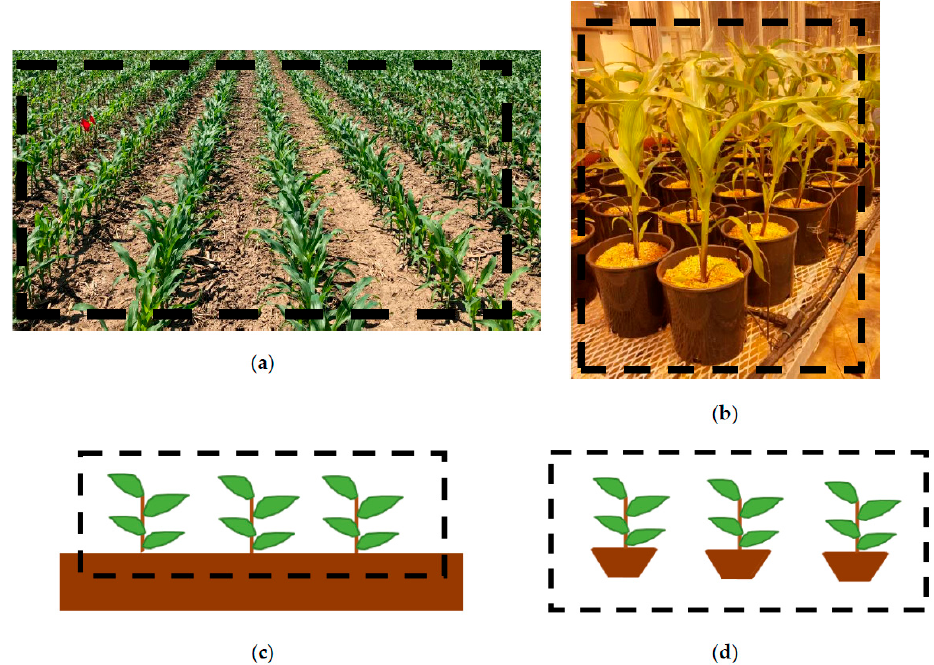
Figure 1. The selected system boundary under ( a ) field and ( b ) greenhouse. ( c ) Crop system boundary surrounds multiple plants and roots, encompassing soil and surrounding air in the field. ( d ) A proxy of crop system boundary surrounds multiple plants, roots, and pots, encompass- ing soil and surrounding air in the greenhouse.